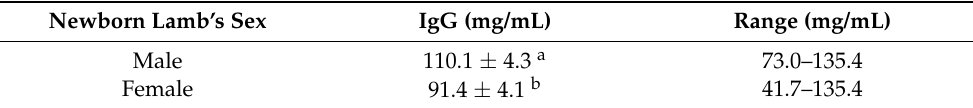
Table 4. Concentration of IgG in ewe’s colostrum, according to the sex of the newborn lamb (means least squares ± standard error).